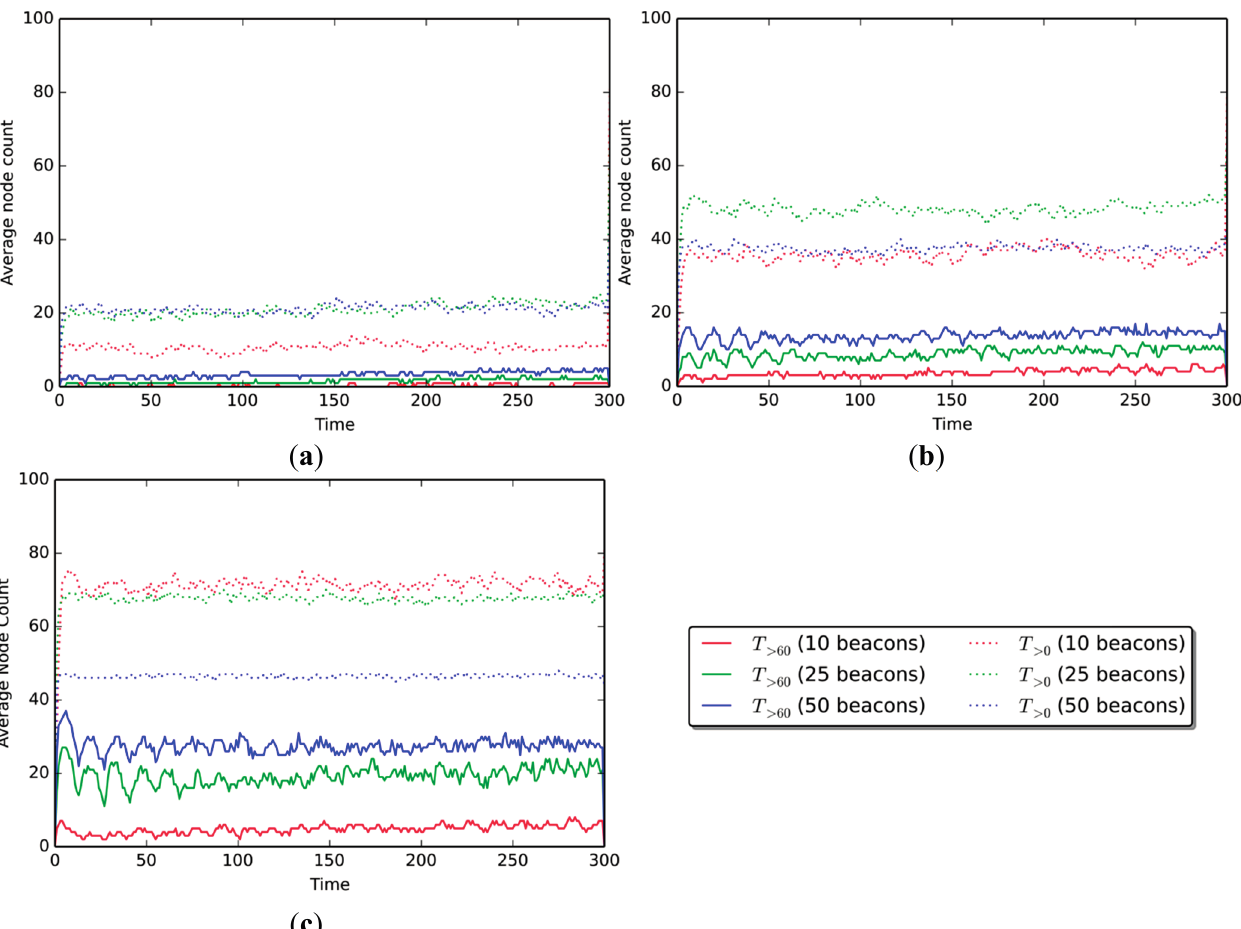
Figure 6. Number of nodes with confidence over the threshold (per number of beacons in scenario) in the ranges of ( a ) 30 m, ( b ) 50 m, and ( c ) 80